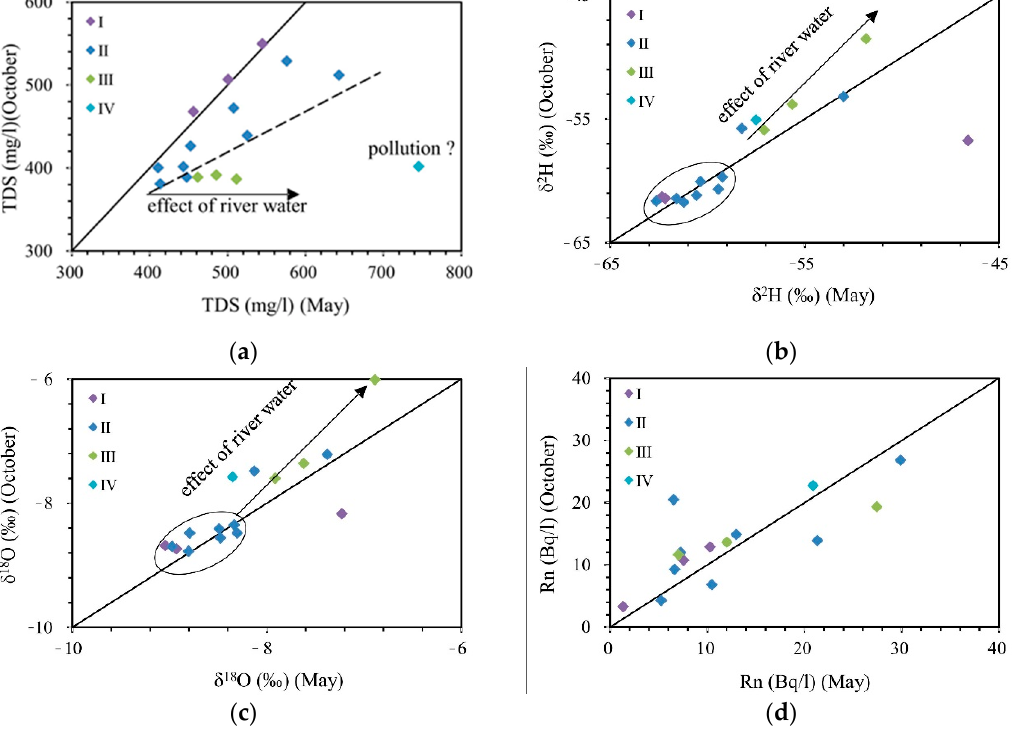
Figure 8. The relationships between TDS ( a ), δ 2 H ( b ), δ 18 O ( c ), and 222 Rn ( d ) for groundwater between May and October.